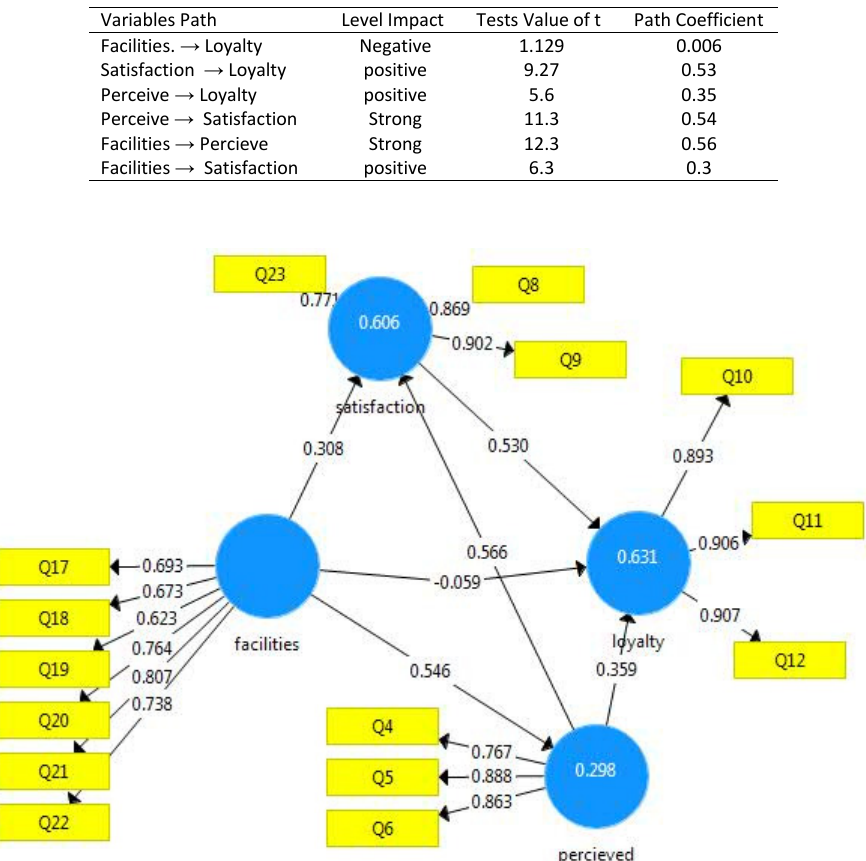
Fig. 1: Results of Hypotheses Fig.1. Results of Hypotheses Test